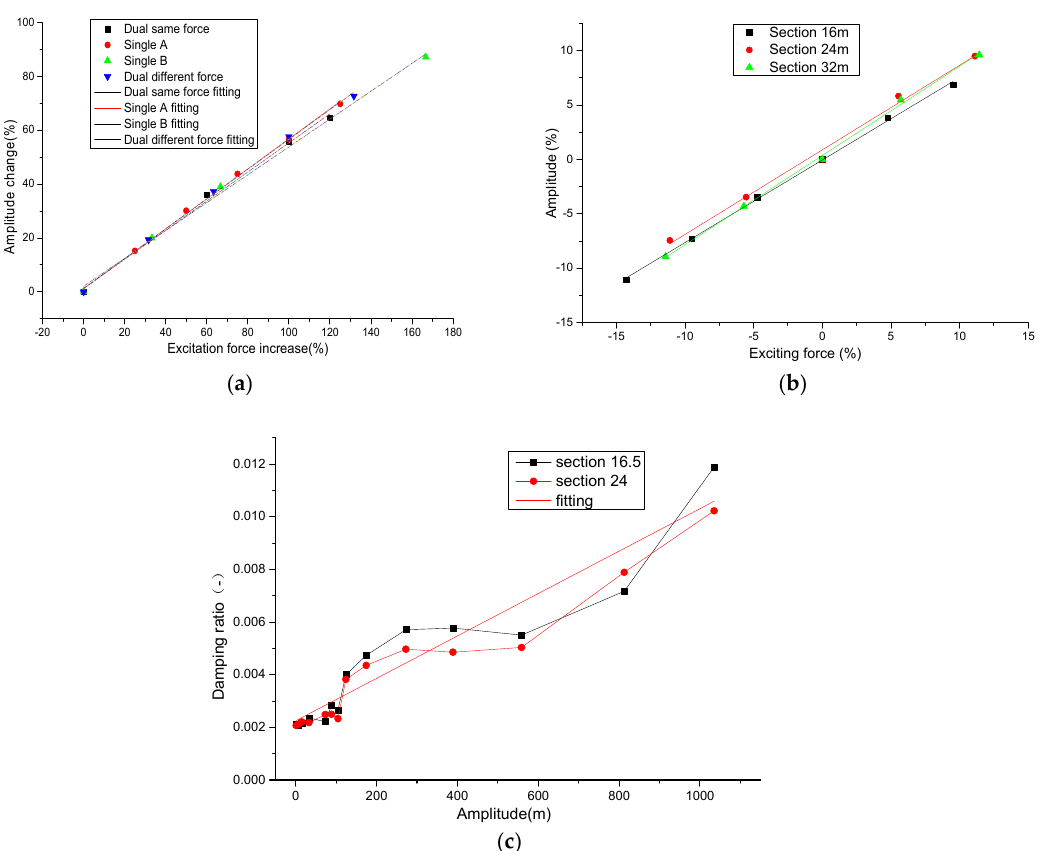
Figure 11. Relationships between excitation forces, damping ratio, and moment amplitude along the blade. ( a ) Relationships between excitation forces and moment amplitude; ( b ) Relationships between the exciting forces at different positions with the amplitude of the blade; ( c ) Relationships between the damping ratio and moment amplitude.